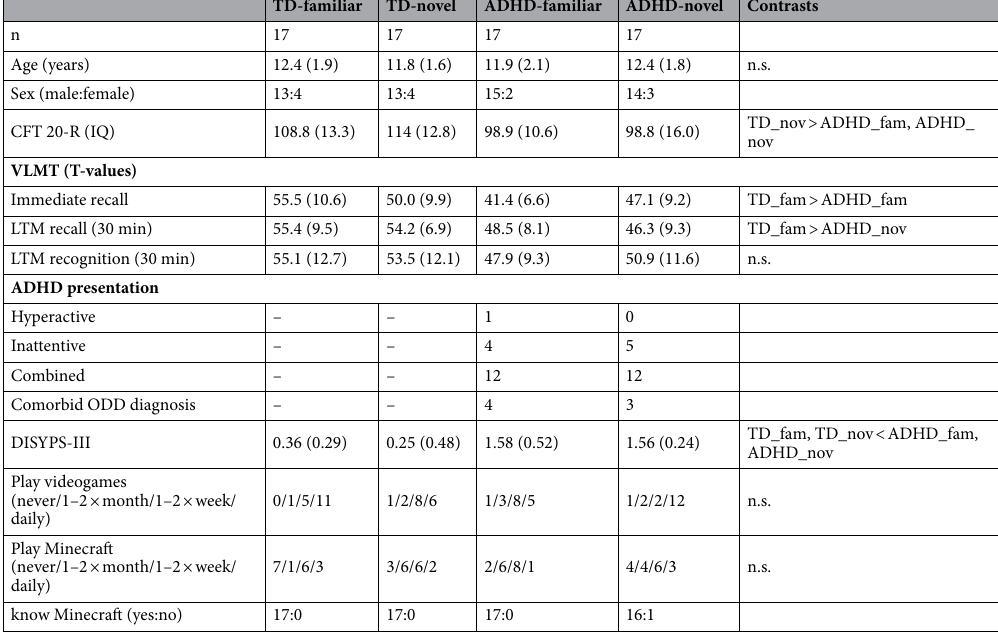
Children and their parents received oral and written information about the contents of the study beforehand. Both were informed that their participation was voluntary and that they could withdraw from the experiment at